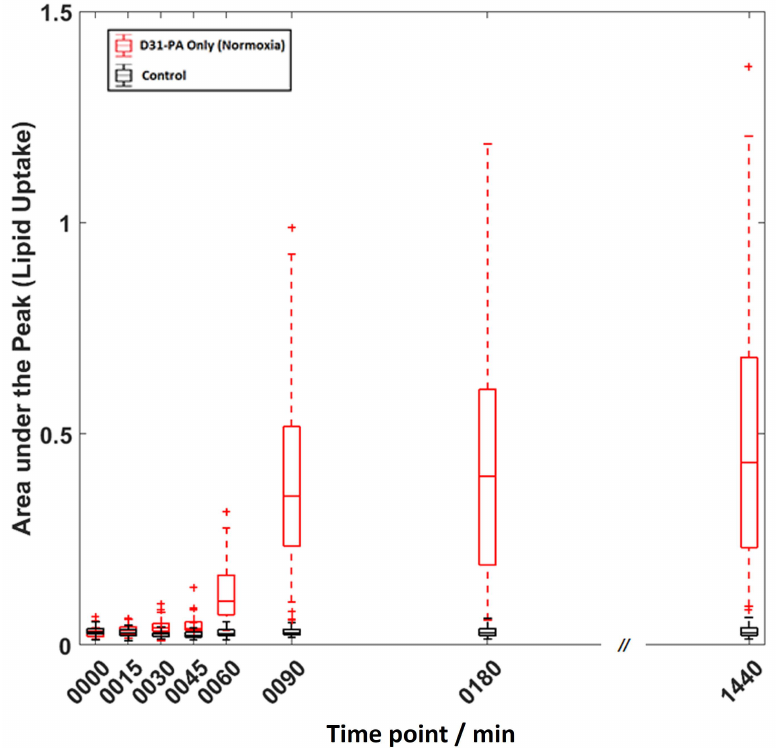
Figure 2. Example box-and-whisker plot for cells treated with D31-PA only under normoxic state and the control experiment. On each box, the central line is the median while the edges of the box are the 25th and 75th percentiles. The whiskers extend to the most extreme data points that are not outliers (within ~99.3% of the data boundary), and the outliers are plotted individually as cross